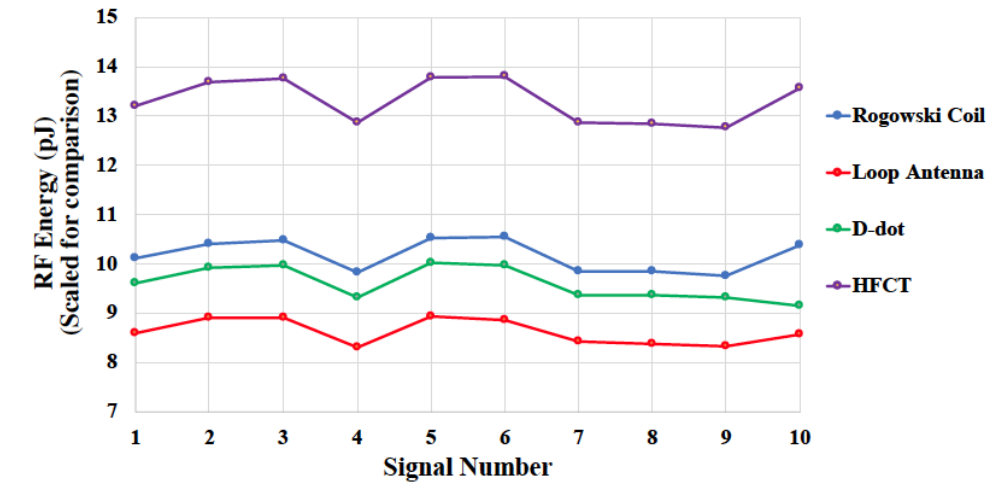
Figure 17. Cumulative energies of the four sensors (values are scaled for